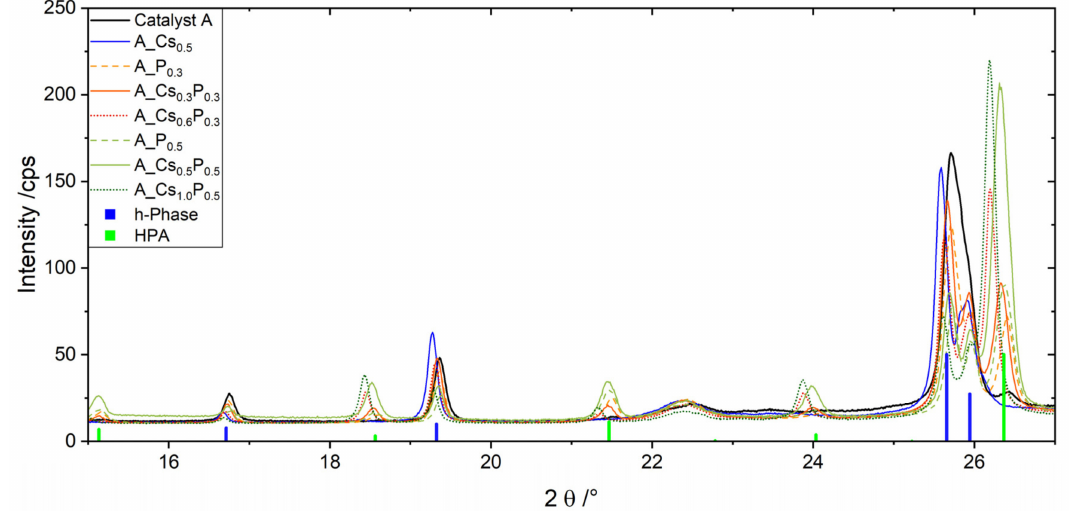
Figure 8. XRD pattern of catalyst A prior to and after adding Cs and P in different Cs/P and (Mo + V + W)/P ratios. Characteristic XRD reflexes of h-phase (blue bars) and HPA (green bars). Table 3. Chemical composition, estimated crystallinity, estimated phase composition, HPA unit cell size and BET-Surface areas of catalyst A with added Cs and P in varied Cs/P and (Mo + V + W)/P ratios. Catalyst Chemical Composition